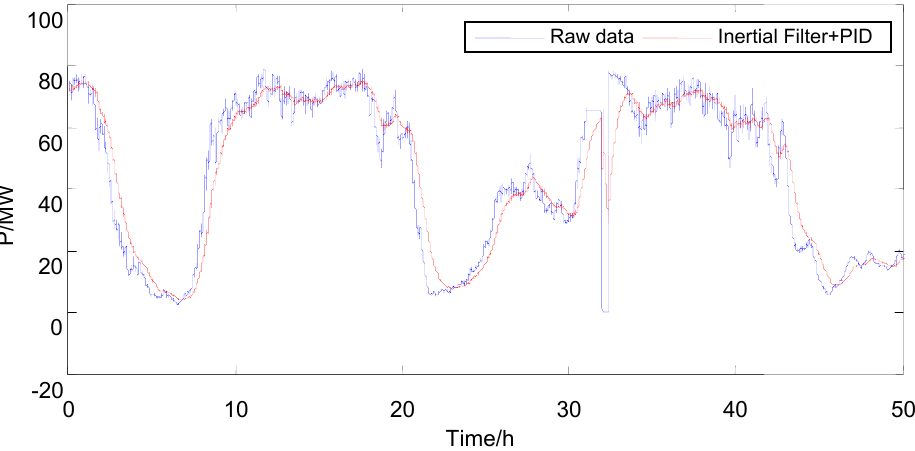
Figure 7. The curve of power smoothing control combining an Inertial Filter with a PID control